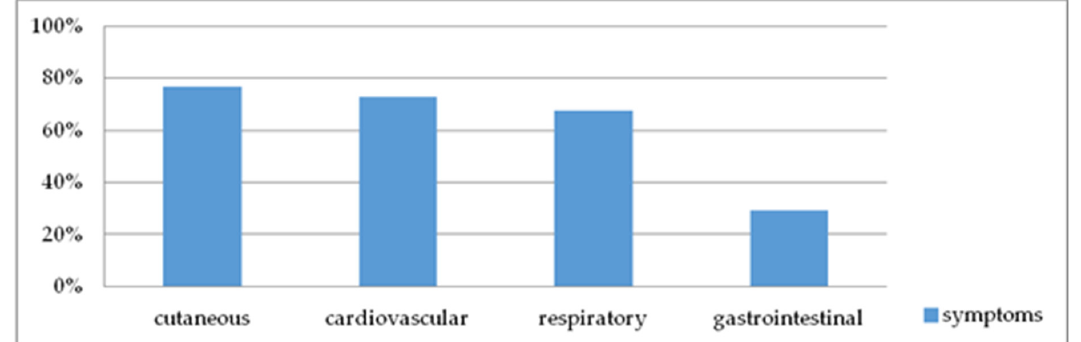
Figure 2. Organ systems involved in anaphylaxis.